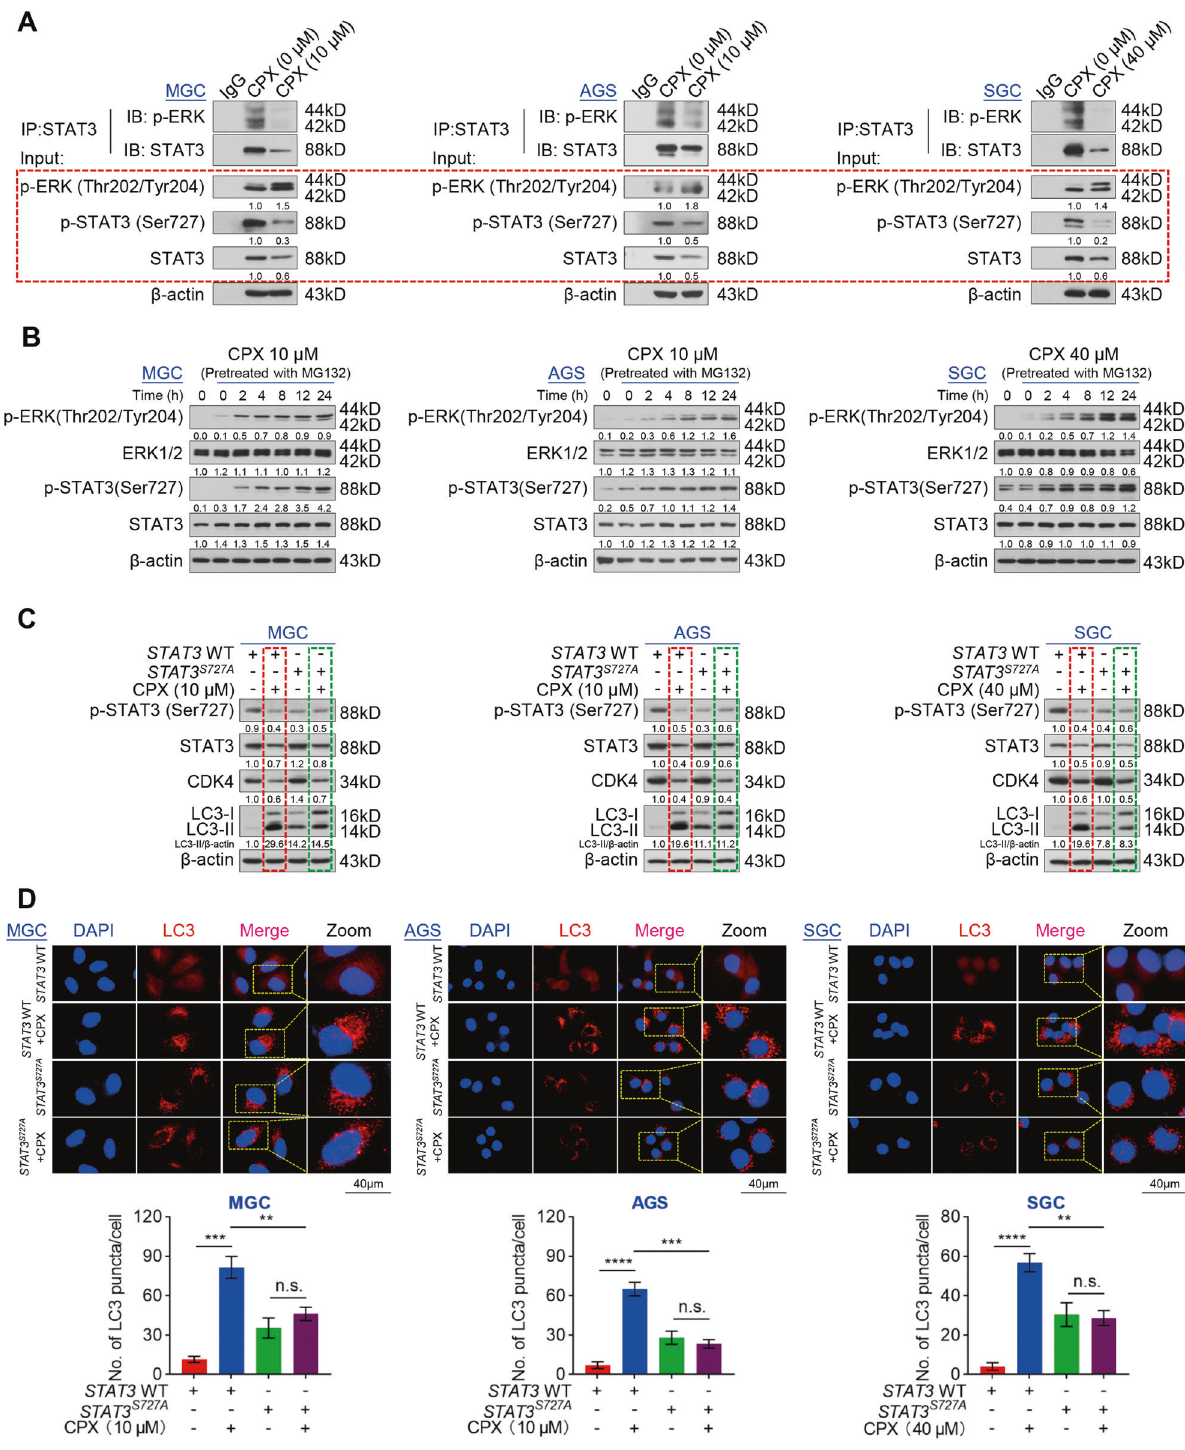
Fig. 5 CPX induces autophagy of GC cells through targeting p-STAT3 (Ser727). A The interaction between p-ERK (Thr202/Tyr204) and STAT3 in GC cells treated with CPX for 24 h. B The protein levels of p-ERK (Thr202/Tyr204), ERK1/2, p-STAT3 (Ser727), and STAT3 in GC cells pretreated with MG132 (MGC: 100 nM; AGS: 100 nM; SGC: 200 nM) for 24 h and then treated with CPX at different times. C Western blotting analysis of p-STAT3 (Ser727), STAT3, CDK4, and LC3 protein levels in STAT3 S727A GC cells treated with CPX for 24 h. D The endogenous LC3 puncta fl uorescence in STAT3 S727A GC cells treated with CPX for 24 h. The ratio of LC3 puncta to cell number was quanti fi ed using ImageJ Plus software (Scale bar, 40 µm). Data were shown as mean ± SD ( n = 3, ** P < 0.01, *** P < 0.001, **** P < 0.0001, or n.s., not signi fi cant by unpaired Student ’ s t test).